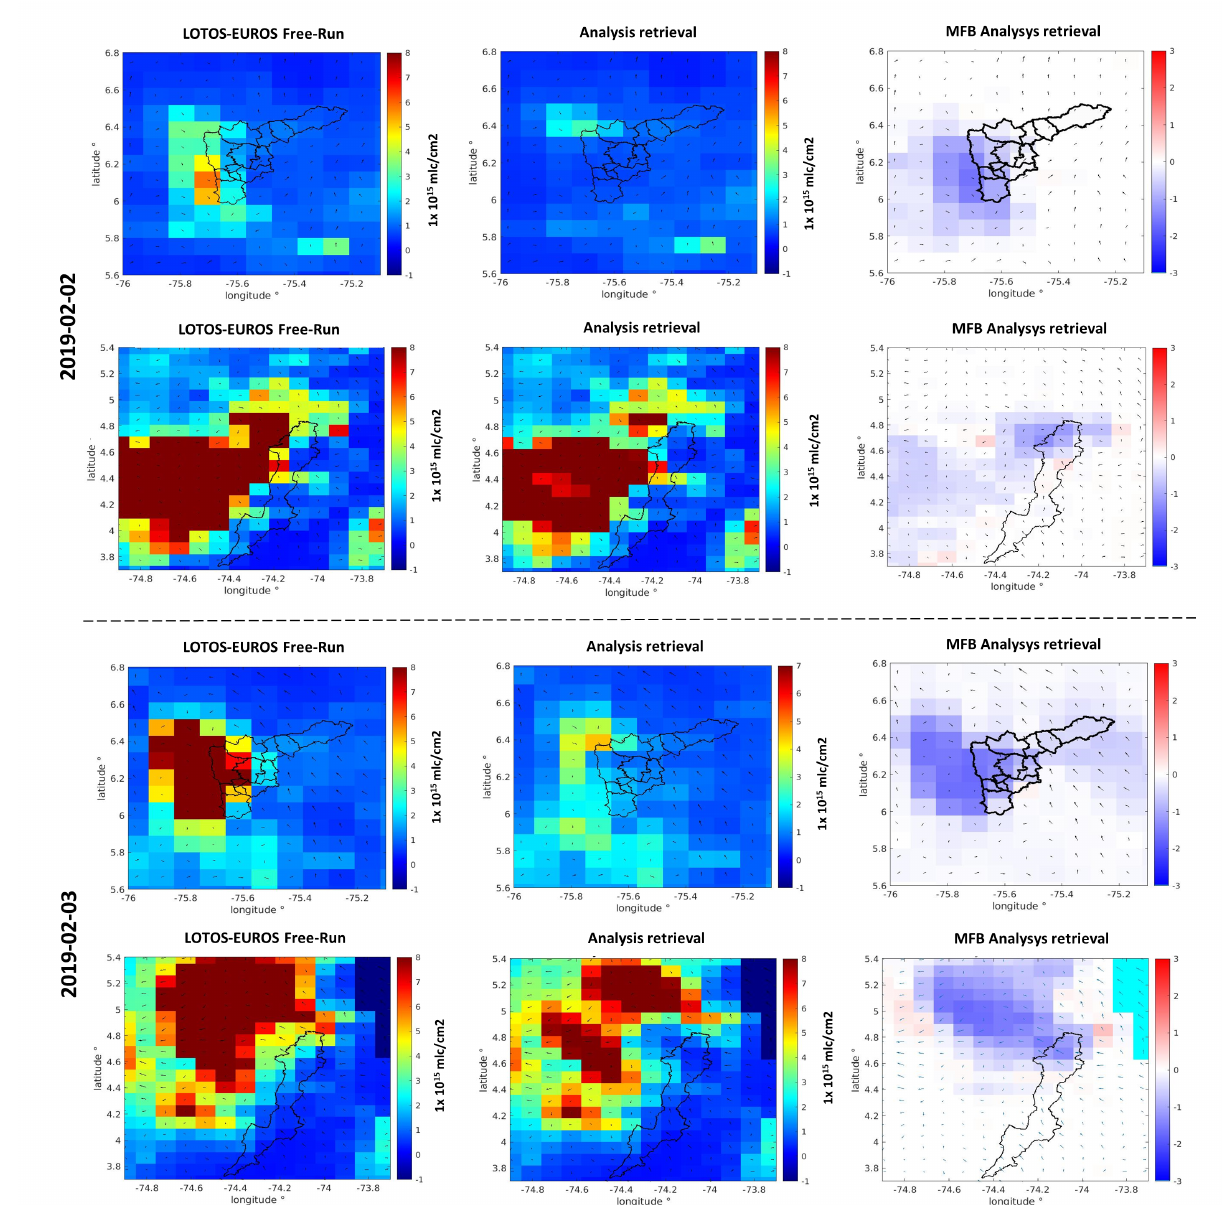
Figure 11. LOTOS-EUROS free run and the analysis run generated from the 4DEnVar results with the Mean Fractional Bias comparison for the 2 February 2019 (three first rows) and for 3 February 2019 (three last rows). For each of the situation the zoom is made for Medellín and Bogo´t. In the right column the statistics is used to quantify the impact of those changes. The cyan color in the last MFB over Bogotá correspond to an absence of data from the gap between the two overpasses of the satellite for this